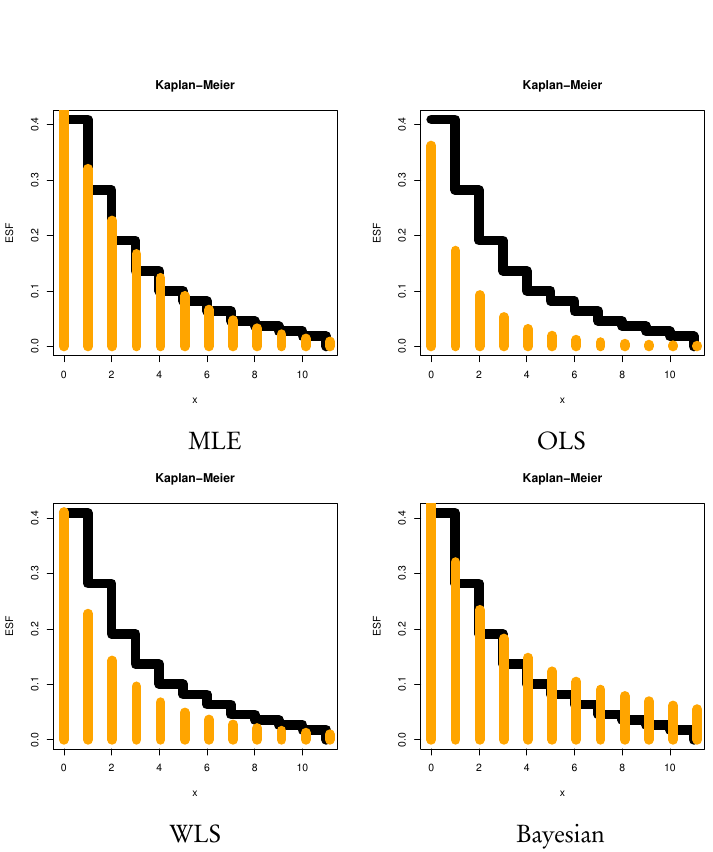
Figure 4 – Kaplan–Meier survival plots for Counts of cysts of kidneys